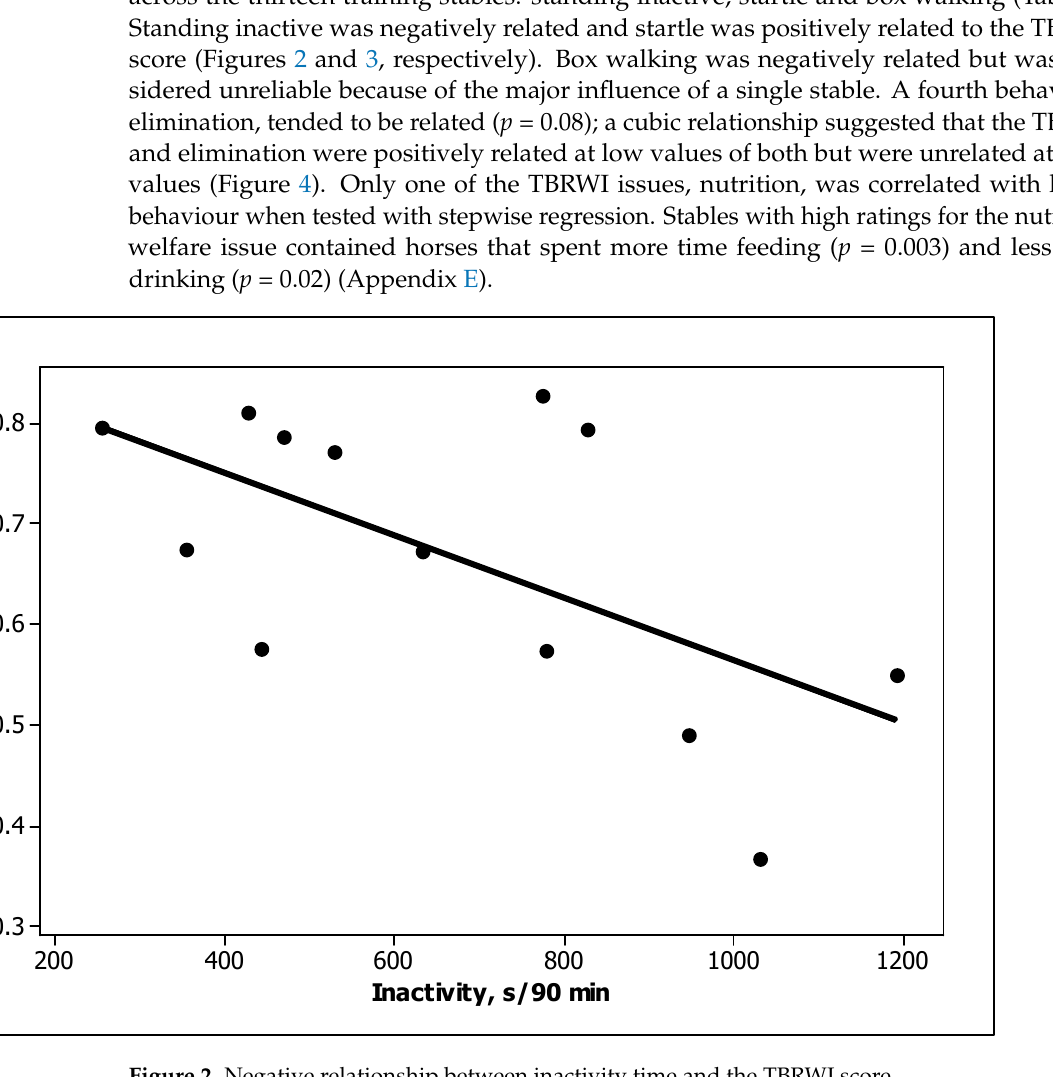
Figure 3. Positive relationship between startle time and the TBRWI score .